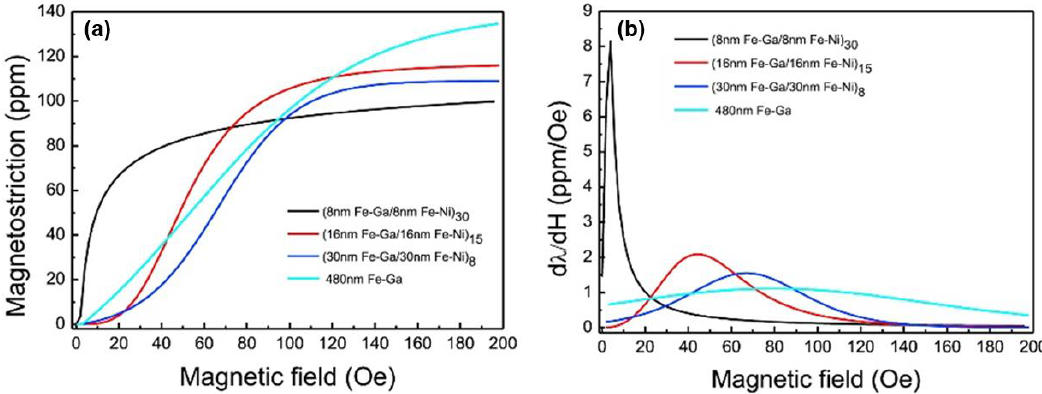
Figure 16. ( a ) and ( b ) are λ-H and dλ/dH-H curves of the samples, λ s of the other samples are 137 ppm, 108